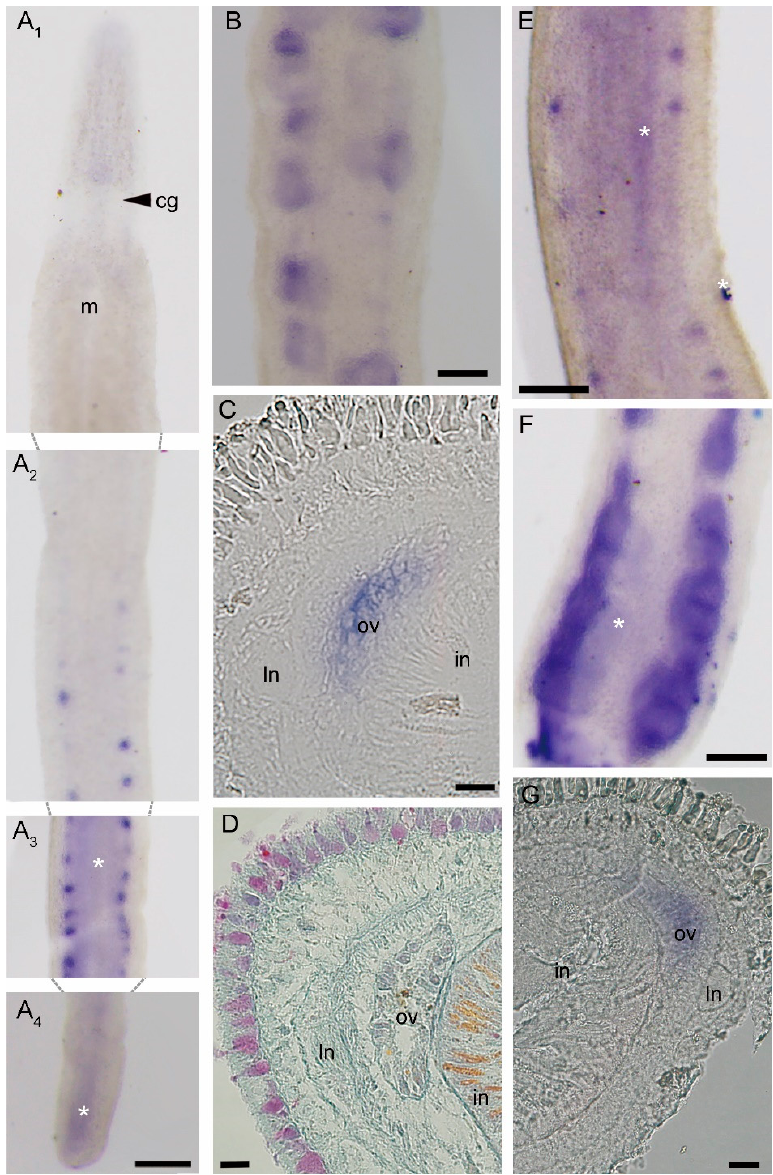
Figure 2. Expression patterns of Ls-piwi1 and Ls-pcna (proliferating cell nuclear antigen) in intact worm of Lineus sanguineus . ( A ) Ls-piwi1 expression in an intact worm, showing it is not expressed in the anterior body region (from head to anterior intestinal region) ( A 1 , A 2 ) and the caudal end ( A 4 ), and is only expressed in ovaries that are distributed in the intestinal region ( A 2 , A 3 ). ( B ) Ls-piwi1 expression in an individual with more developed ovaries. ( C ) Transverse frozen section of a Ls-piwi1 in situ hybridized specimen through the region of A 3 . ( D ) Transverse section of intestinal region (Mallory trichrome staining) showing the shape and position of ovaries. ( E , F ) Ls-pcna expression in two different individuals with ovaries at different developmental stages. ( G ) Transverse frozen section from ( E ). Abbreviations: cg, cerebral ganglia; in, intestine; ln, lateral nerve; m, mouth; ov, ovary. Asterisks mark nonspecific staining (unexpected spots on body surface and diffuse staining in intestine; see Figure S4, Supplementary Materials). Scale bars: A,B,E,F = 200 μ m; C,D,G = 20 μ m.